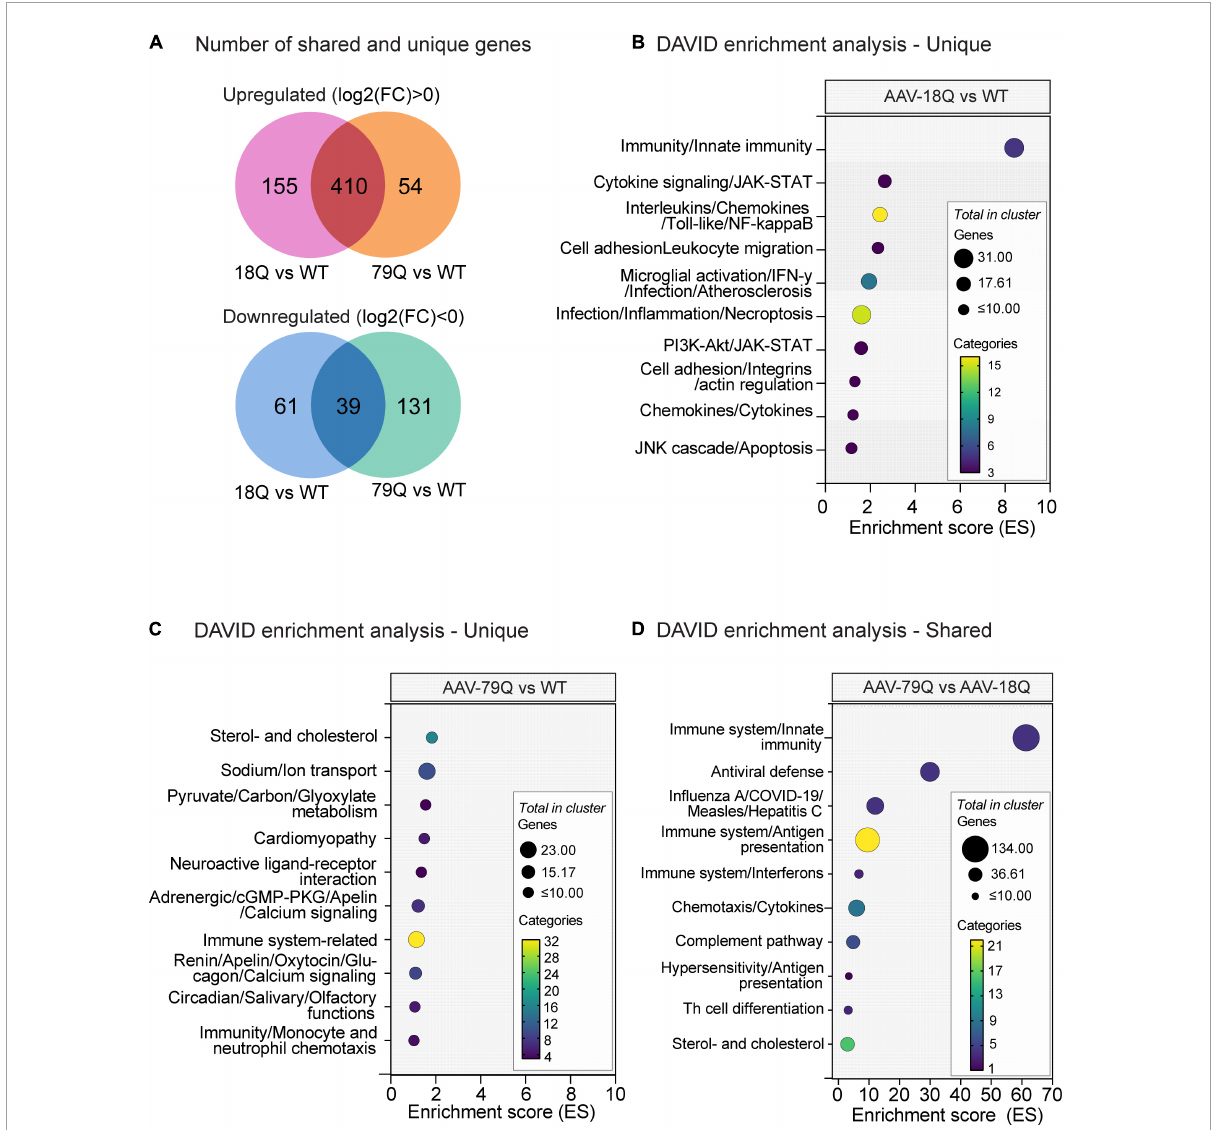
FIGURE2 DAVID Functional Annotation Clustering of unique and shared genes between the 18Q vs. WT and 79Q vs. Wild type (WT) datasets. 18Q vs. WT and 79Q vs. WT datasets were filtered based on adj. p < 0.05 and separated into three gene sets: shared genes, genes unique for 18Q vs. WT, and genes unique for 79Q vs. WT. Functional Annotation Clustering was performed using the DAVID bioinformatics resource (Huang da et al., 2009; Sherman et al., 2022) on each gene set. Categories used for clustering were KEGG pathways and Biological process (BP) from GO and keyword BP from Uniprot. (A) Venn diagram showing the number of shared and unique genes between 18Q vs. WT and 79Q vs. WT, shown as separated by log2(FC) < 0 and log2(FC) > 0. (B–D) The top 10 DAVID annotation clusters (based on enrichment score, ES). The y-axis denotes annotation clusters; the full output and lists of each respective gene set can be found in Supplementary Data Sheet 2 . (B) Unique gene set (adj. p < 0.05) in 18Q vs. WT, (C) unique gene set (adj. p < 0.05) in 79Q vs. WT, and (D) shared gene set (adj. p < 0.05) between the 18Q vs. WT and 79Q vs. WT datasets. DAVID, database for annotation, visualization, and integrated discovery; GO, gene ontology; ES, enrichment score; 79Q, HTT853-79Q vector; 18Q, HTT853-18Q vector; limma, linear models for microarray data, FC, fold